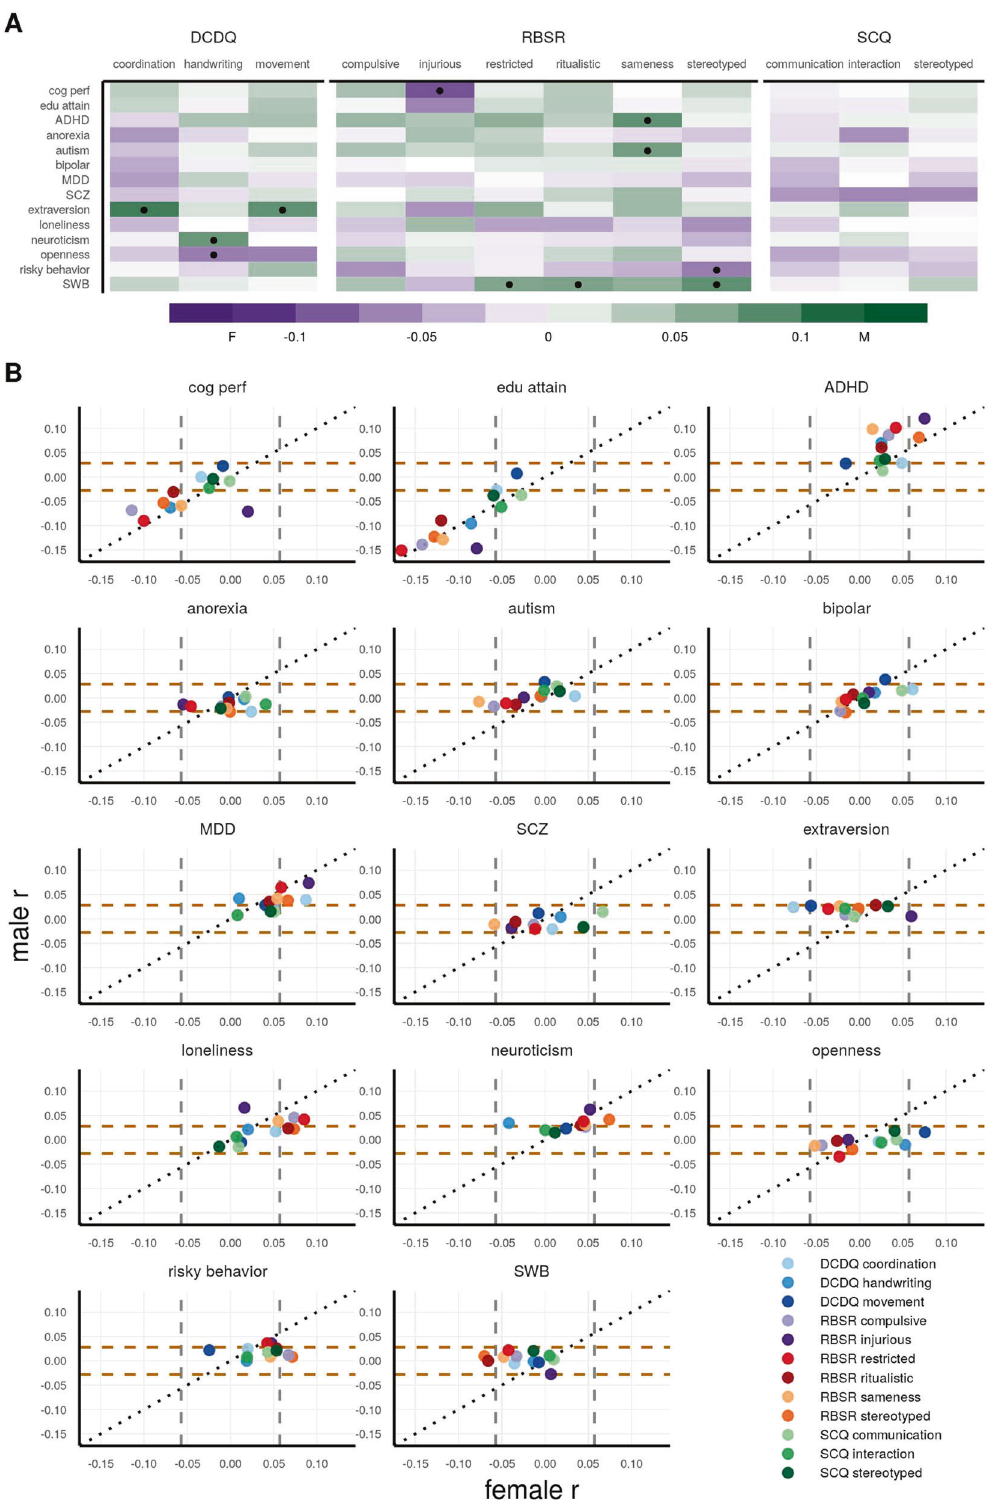
Fig. 6 PGS sex interactions and sex-strati fi ed correlations with the autism subscales in SPARK. A The PGS β estimate from the sex interaction modeling is shown with the fi ll color, with one dot indicating the PGS by sex interaction term was nominally signi fi cant. A positive β (green) indicates higher PGS by sex interaction for males, whereas a negative β (purple) indicates higher PGS by sex interaction for females. B Pearson r coef fi cient correlations for the female correlation (x-axis) vs. male correlation (y-axis) are plotted. The gray vertical lines indicate the bounds of nominal signi fi cance for females, and the brown horizontal lines indicate the bounds for males. N = 1177 females and N = 4887 males. PGS names are cog perf = cognitive performance, edu attain = educational attainment, MDD = major depression disorder, SCZ = schizophrenia, SWB = subjective